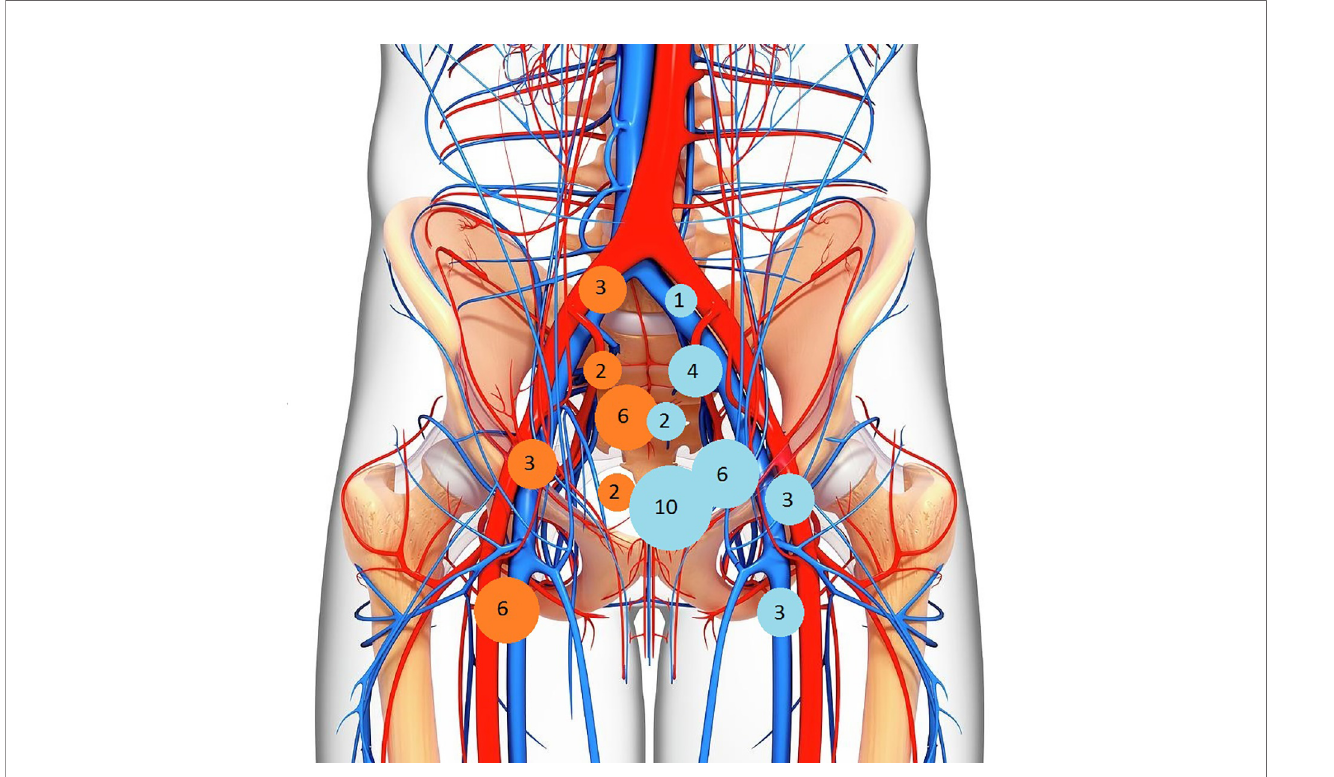
FIGURE 1 | Mapping of cases with PET-positive (orange) and MRI-positive (light-blue) lymph